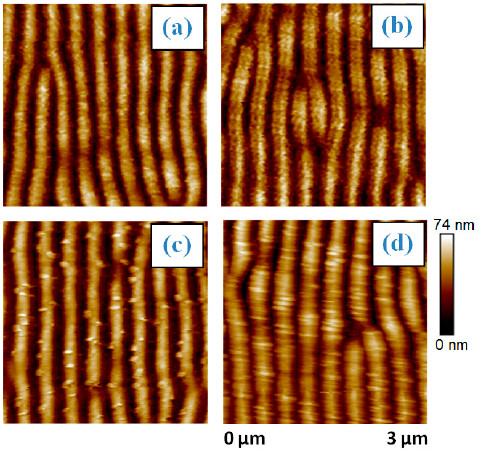
Figure 1. Surface morpgholgies of ( a ) pristine silver grating; ( b ) silver grating treated with temperature; ( c ) humidity; ( d ) with temperature and humidity(Figure